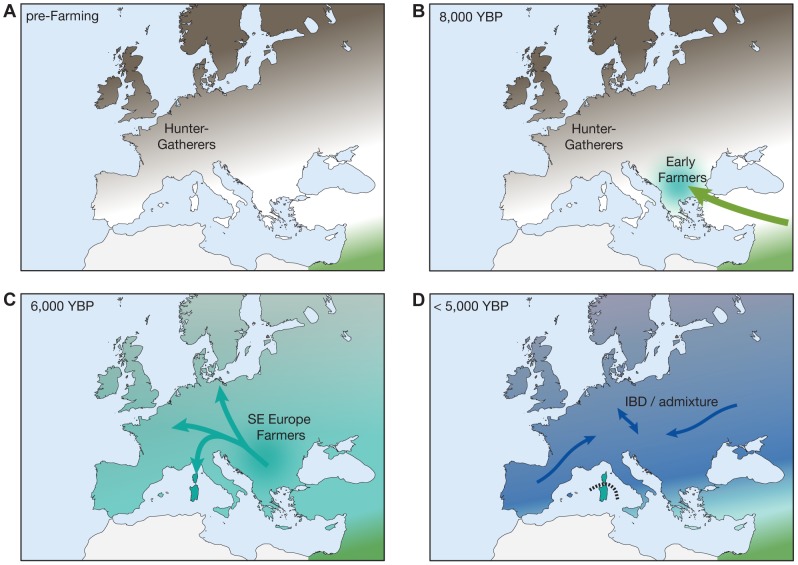
A simplified model for recent demographic history of Europeans.The panels indicate a possible demographic scenario consistent with the observed signals. (A) Mesolithic HGs present in mainland Europe prior to the arrival of agriculture. (B) Initial spread of farming from the Middle East beginning from 7,000 YBP into SE Europe. (C) Expansion of farming to N Europe from SE European gene pool and establishment of main S-N gradient of genetic diversity. Wave of migration also reaches Sardinia. (D) Continuous population expansion and admixture with local HGs as well as additional migrations continues to shape genetic diversity in mainland Europe, but Sardinia remains mostly isolated (IBD: isolation by distance).